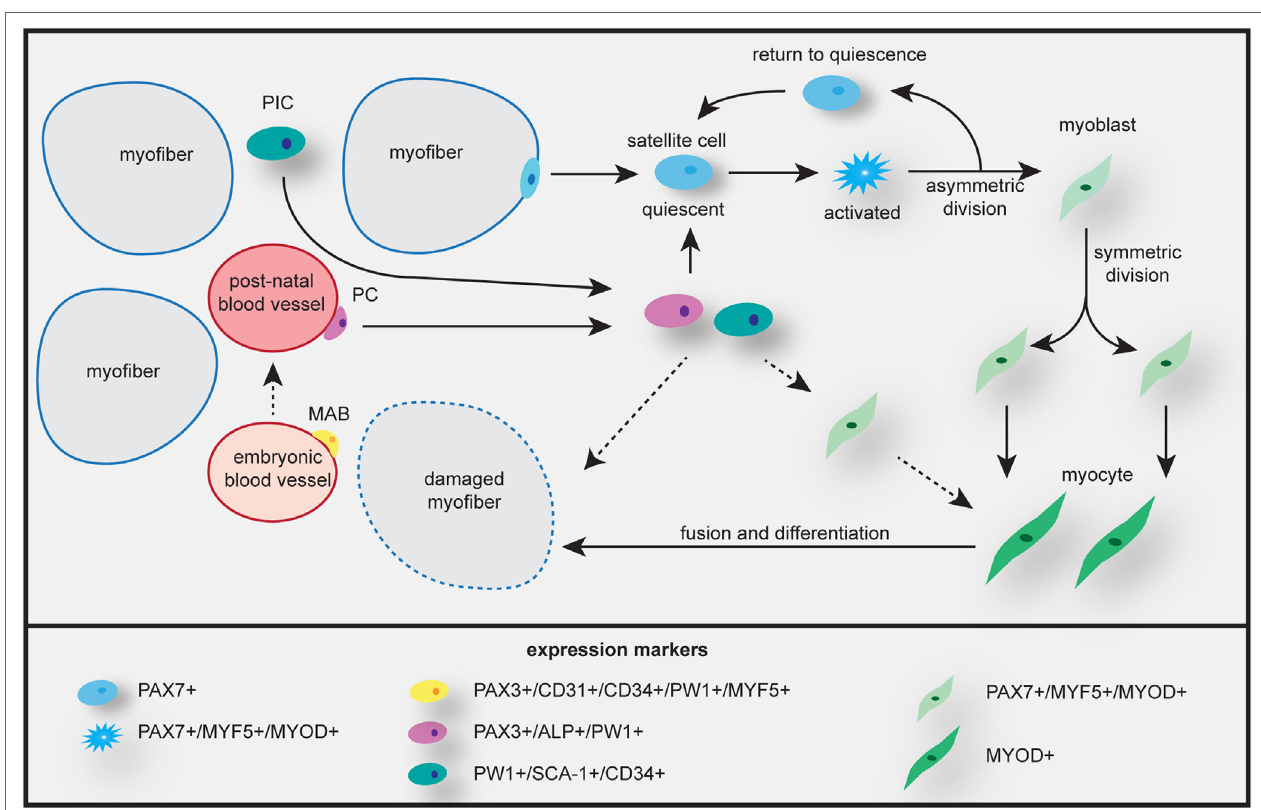
FiGURe 3 | Skeletal muscle growth, maintenance, and repair by different myogenic progenitor cells. Satellite cells from the basal lamina of the myofiber are activated and undergo asymmetric and symmetric division to generate heterogeneous progeny. Some cells undergo self-renewal and return to quiescence, others become myoblast that will proliferate and differentiate to become myocytes, which fuse to myofibers, enabling repair and/or growth. Mesoangioblasts (MABs) can contribute to muscle regeneration during embryonic growth, while pericytes (PCs) are involved in postnatal muscle growth by repopulating the quiescent stem cell population or maybe by transforming into a myoblast. Participation in growth and/or repair or direct fusion with the myofiber probably occurs along the same pathways as given for satellite cells. Uncertainties in cell fate are indicated by dashed arrows. PW1 + interstitial cells (PICs) are mostly involved in perinatal growth. Expression signatures of differentiation markers in all different cell types are listed at the bottom.